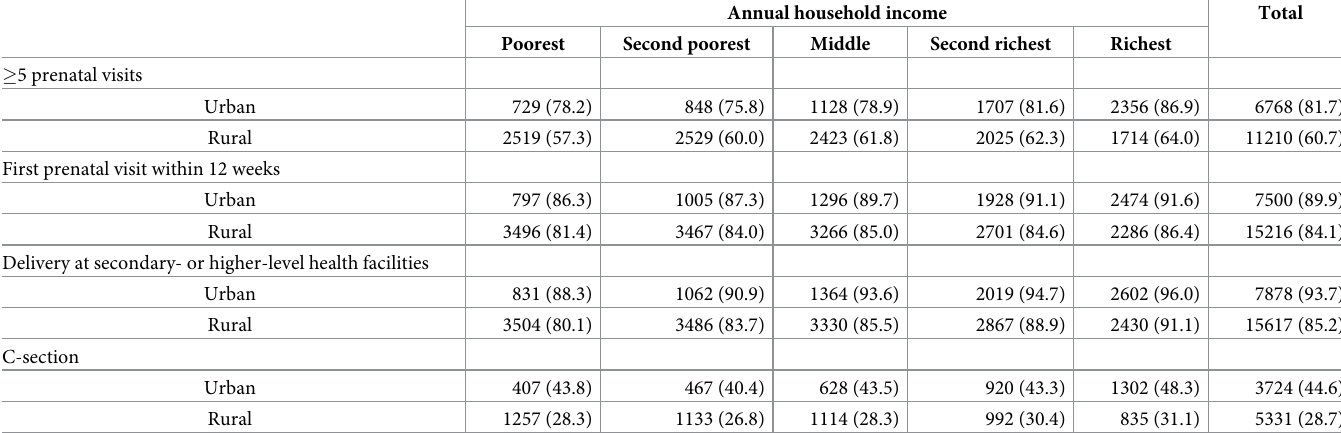
Table 2. Timing and frequency of prenatal visits and delivery care by annual household income in urban and rural areas.